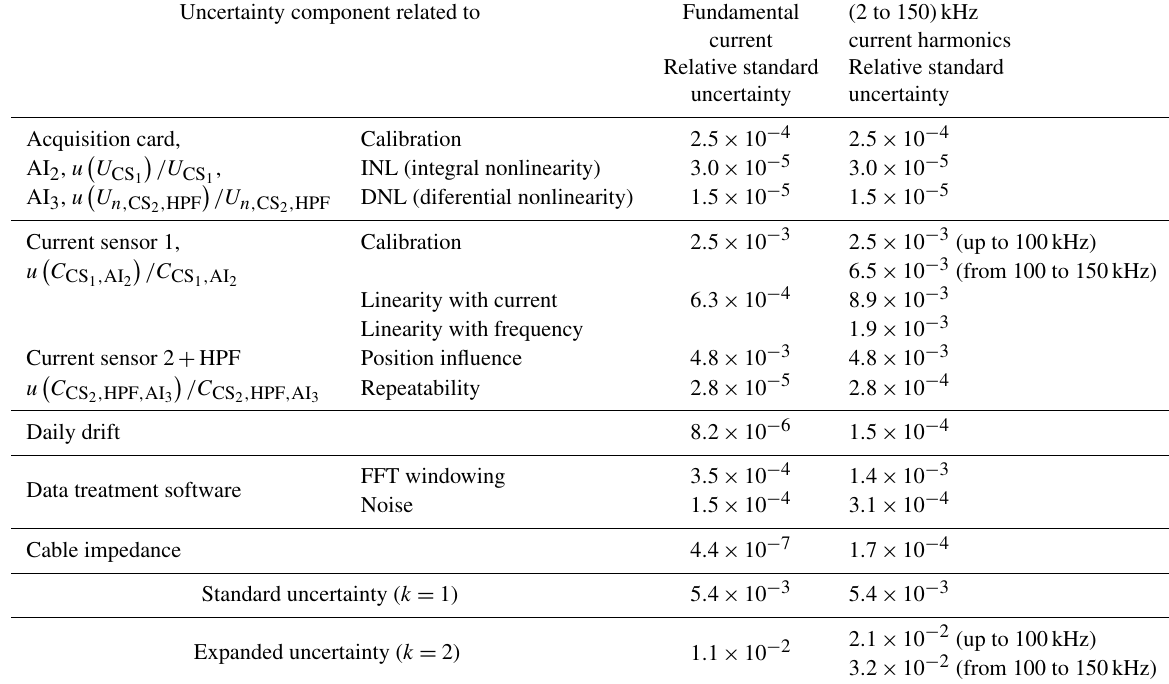
Table 2. Uncertainty budget for fundamental and (2 to 150)kHz current harmonics. Uncertainty component related to Fundamental (2 to 150)kHz current current harmonics Relative standard Relative standard uncertainty uncertainty Acquisition card, Calibration 2 . 5 × 10 − 4 2 . 5 × 10 − 4 3 . 0 × 10 −